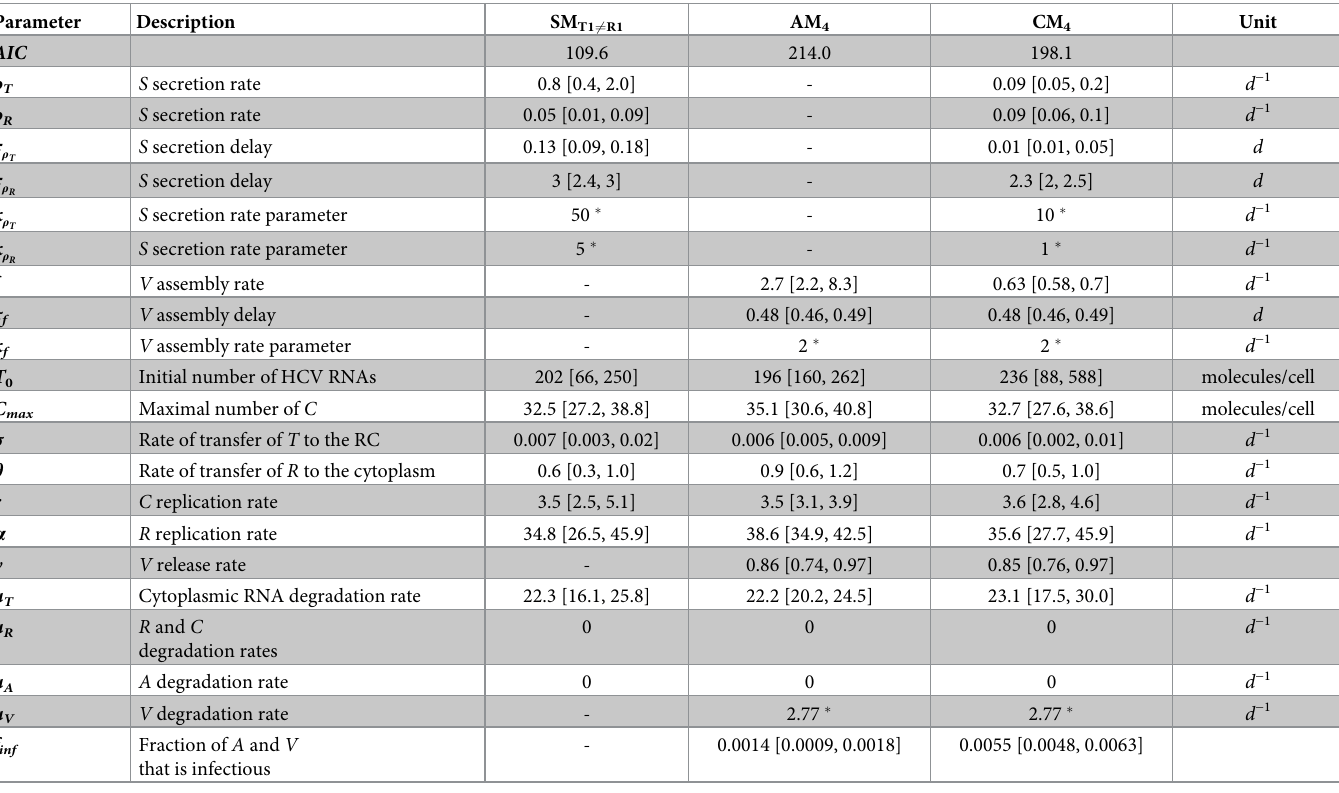
Table 4. Parameter values and 95% confidence intervals of the best-fit models SM T1 6¼ R1 , AM 4 , and CM 4 . Note that parameter values marked with � were fixed due to previous assumptions (time delay parameters: k S3, S4 and S5 Figs.